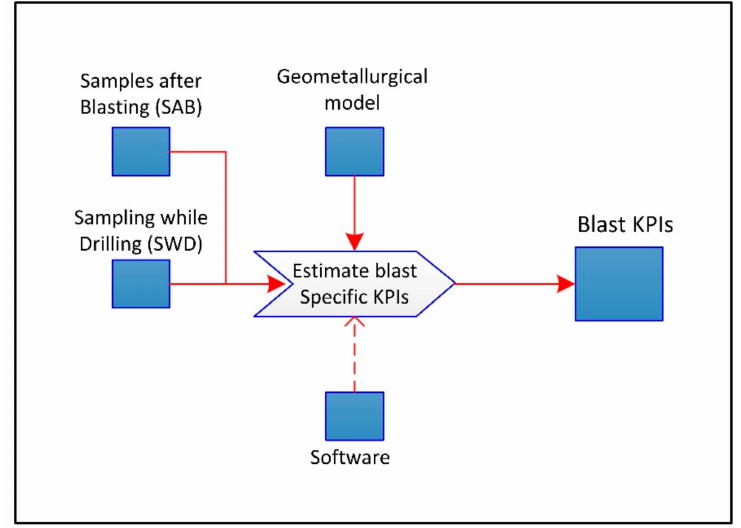
Figure 10. Geometallurgical model used as a controlling element for estimation of blast specific KPIs (key performance